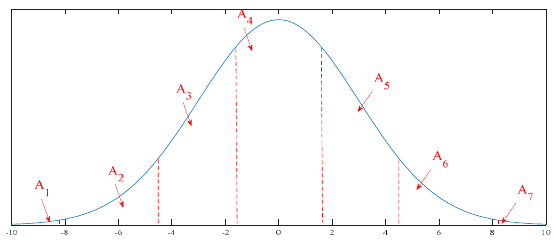
Figure 2. Sample for seven parts: A 1 , A 2 , A 3 , A 4 , A 5 , A 6 , and A 7 corresponding to 0.4%, 5.8%, 24.6%, 38.4%, 24.6%, 5.8%, and 0.4%, respectively.